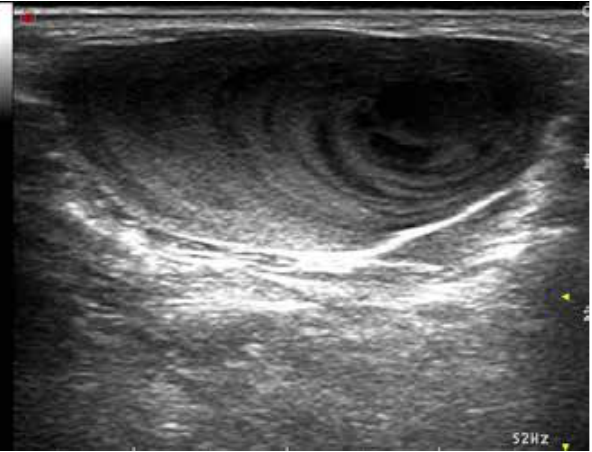
Figure 1 Ultrasonography showing “turbulent flow” within the